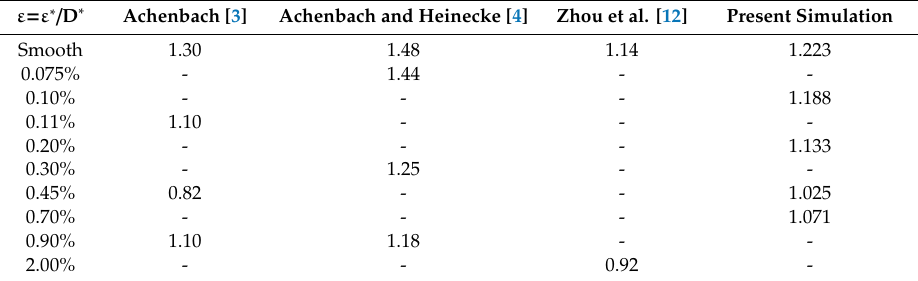
Table 1. Summary for the drag coe ffi cient at Re = 1.0 × 10 5